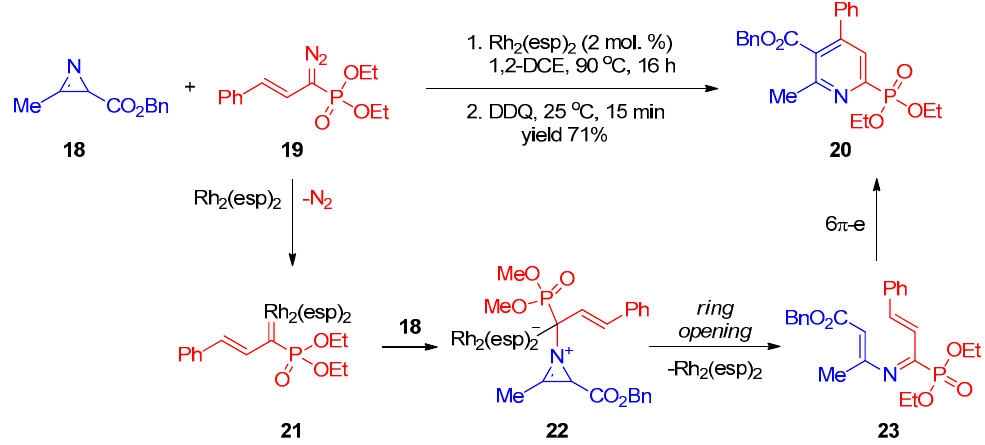
Scheme 4. Reaction of phosphorylated carbenoid with 2 Н